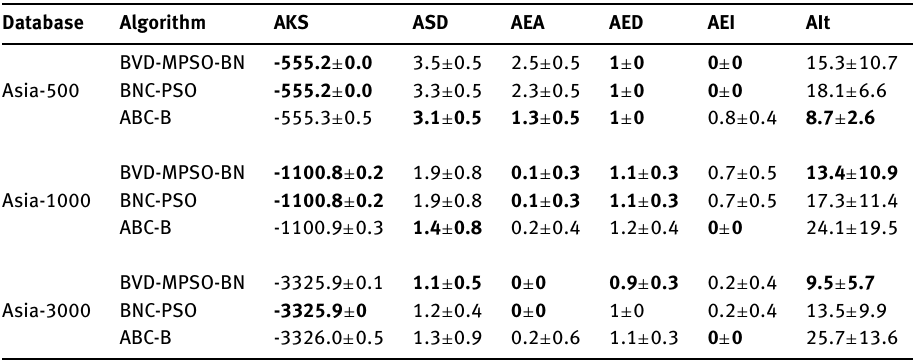
Table 5. The experimental results of three algorithms on Asia network Database